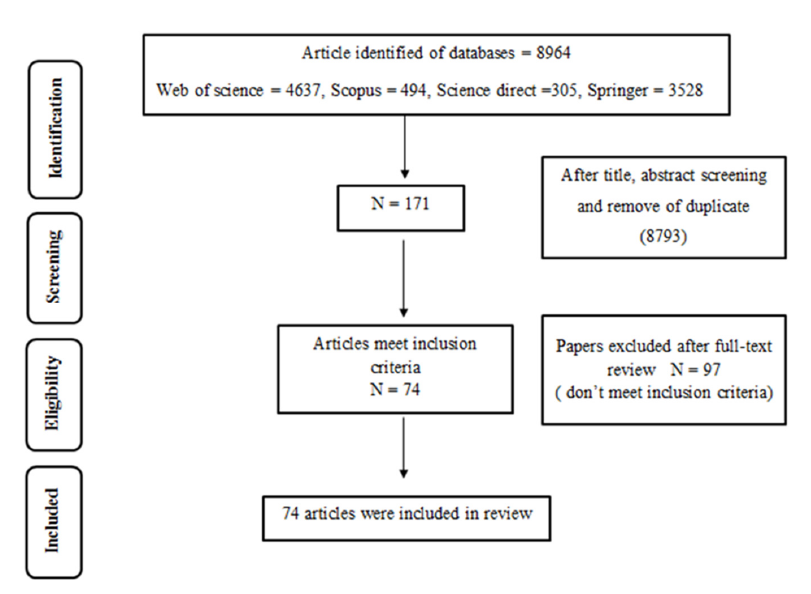
Figure 2. Figure 2.Figure 2. Figure 2. Flowchart for systematic literature